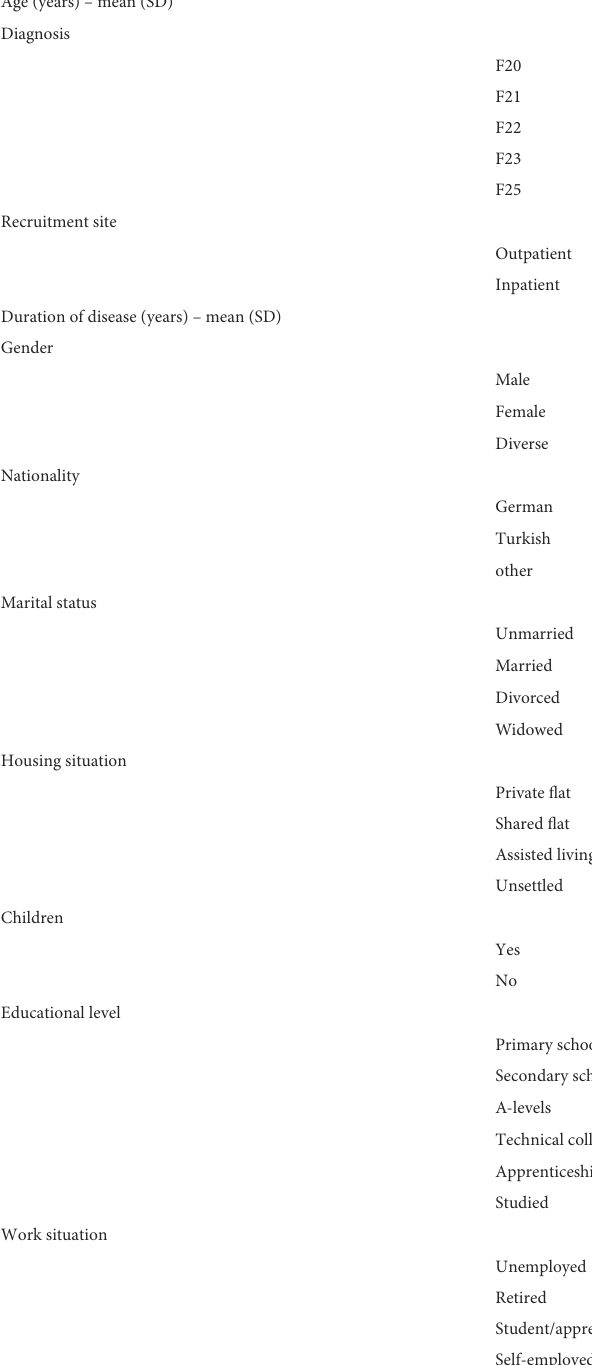
TABLE 1 Sociodemographic characteristics.